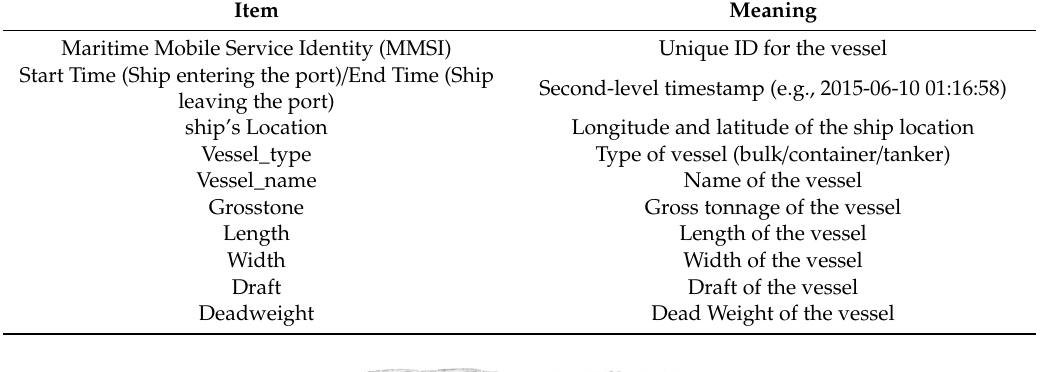
Table 2. Data categories in OD dataset of vessels.